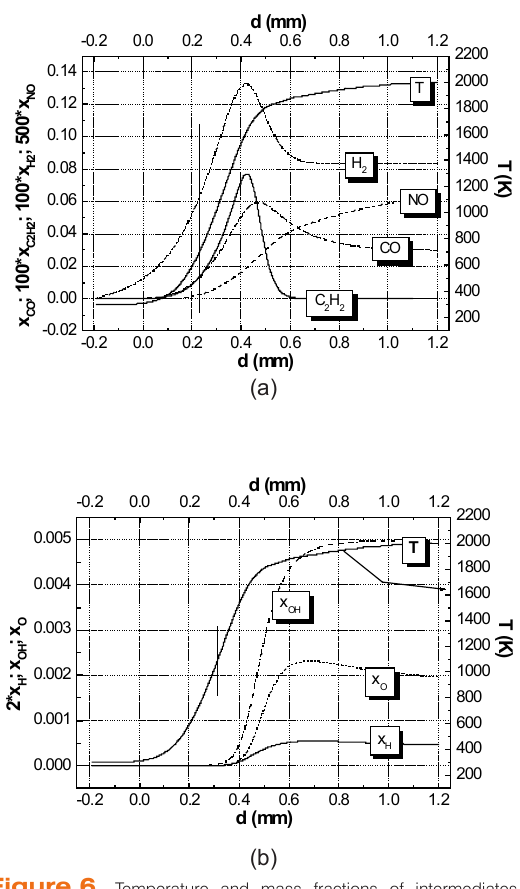
H -air flame. 2 6